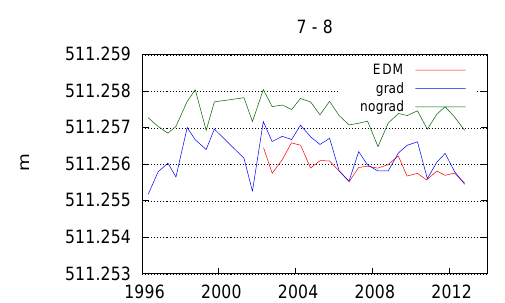
modelmappedwithDryNiellmappingfunction. Zenithpathdelay